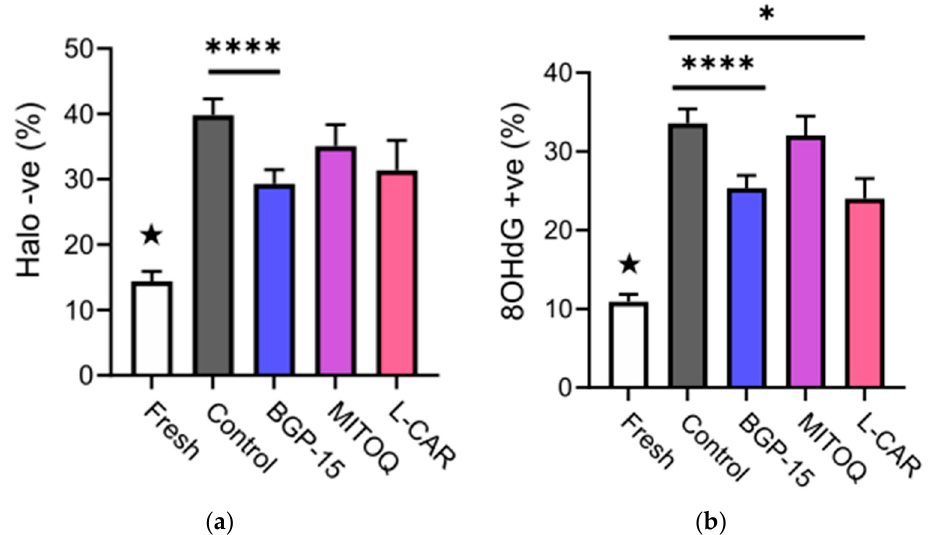
Figure 3. Effect of mitochondrial activators on sperm DNA damage markers. ( a ) Percentage of sperm with DNA fragmentation for pre- (fresh) and post-cryopreservation; ( b ) Percentage of sperm with DNA oxidative damage. Fresh (n = 34), control (n = 34), BGP-15 (n = 34), MitoQ (n = 22), L-car (n = 11). Data shown as mean ± SEM. Statistical analysis was the repeated measures mixed model with post-hoc pairwise comparisons. ★ indicates that all cryopreserved groups are significantly different from the fresh group; * p < 0.05, **** p < 0.0001.